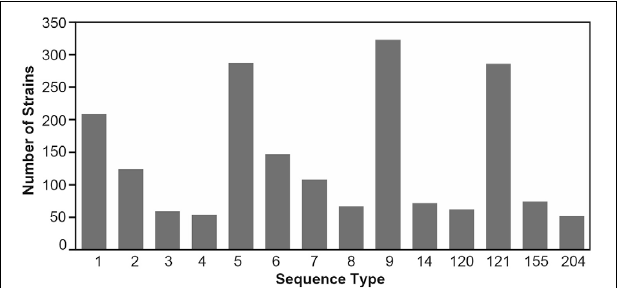
FIGURE 1 | The number of Listeria monocytogenes genomes per ST included in this study. Supplementary Table 2 contains additional details on the